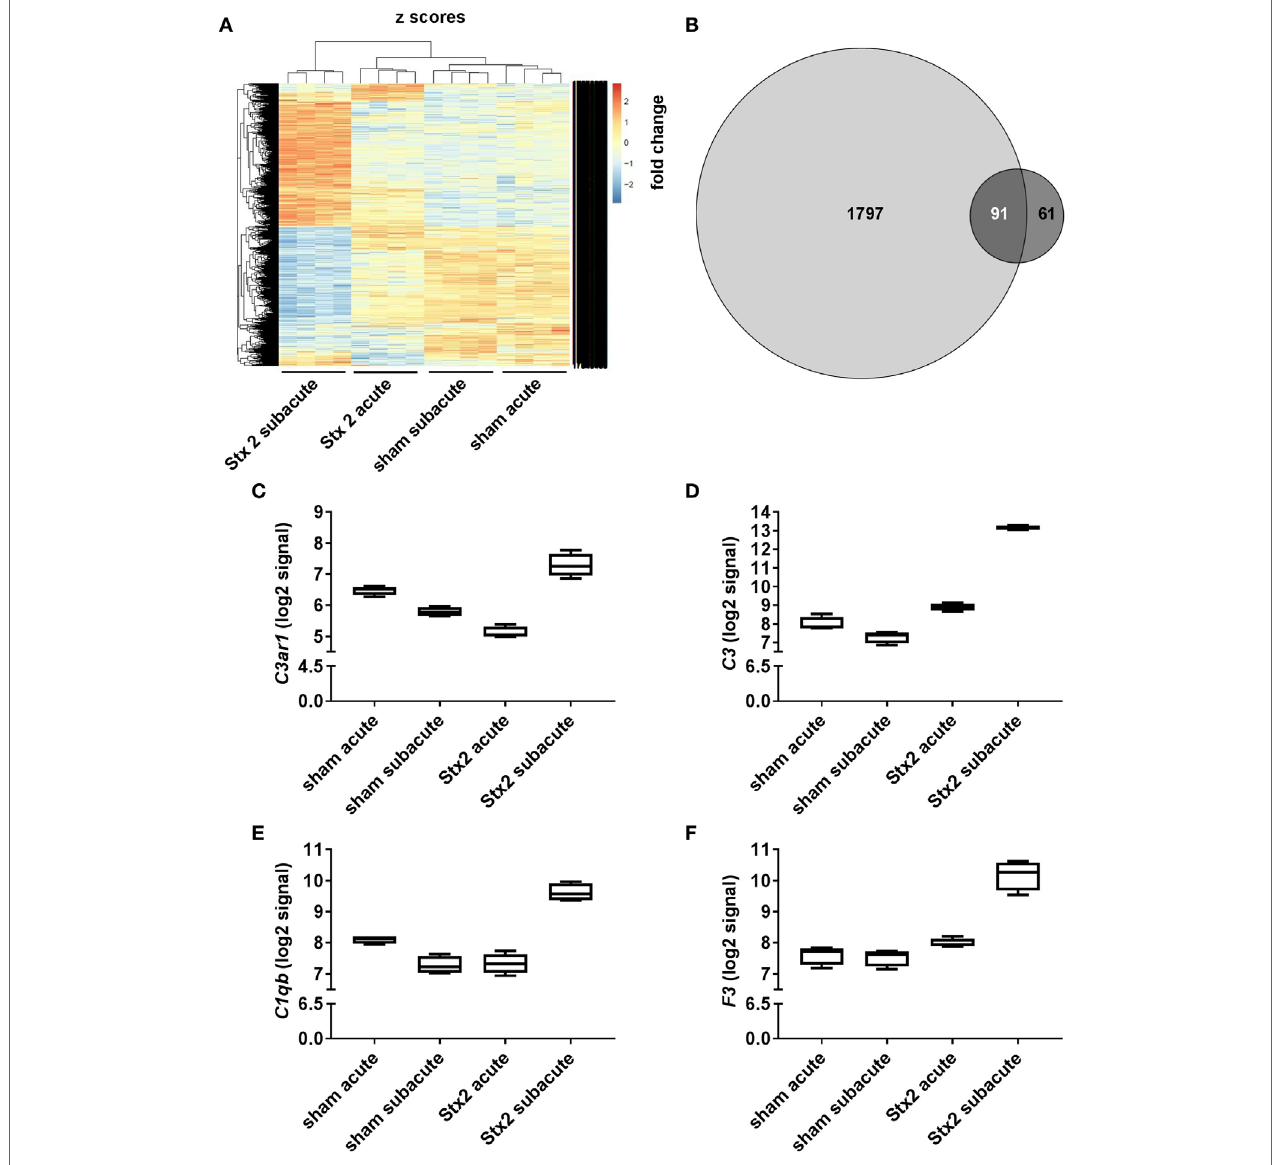
FigUre 10 | Changes in renal gene expression in response to different Stx2 regimens. (a) Heat map of features obtained from ANOVA filtering adjusted p < 0.05 comprising z -score scaled values. In each group, n = 4 animals were studied. (B) Proportional Venn diagram of differentially expressed genes according to the limit fold change for acute (dark gray) vs. subacute model (light gray). Number of overlapping genes is highlighted in white. Gene expression data were filtered for candidate genes from complement pathway. Log2 signals for (c) complement C3a receptor 1 ( C3ar1 ), (D) complement factor C3 ( C3 ), (e) complement C1q B chain ( C1qb ), and (F) tissue factor ( F3 ) are illustrated by box